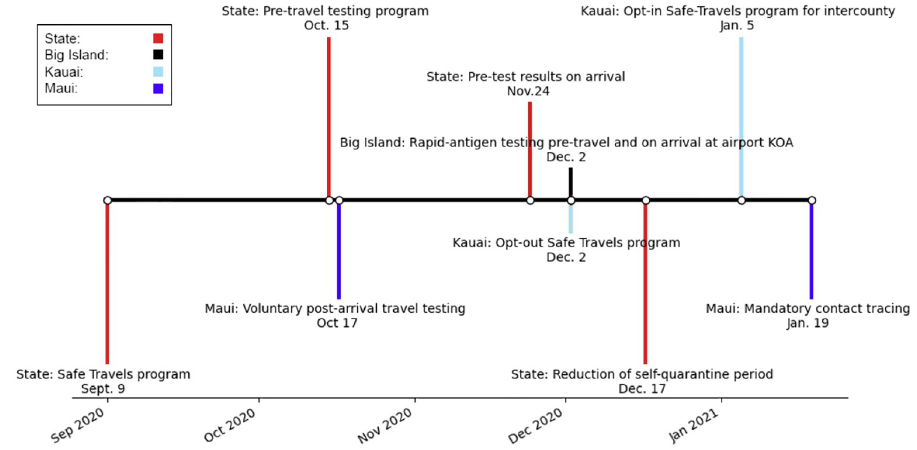
Fig 3. Safe travel protocols per counties. Kaua‘i county has the most restricted travel regulations since Dec. 2, 2020 following a significant initial surge in cases with the introduction of the Safe Travels Program on October 15, 2020.